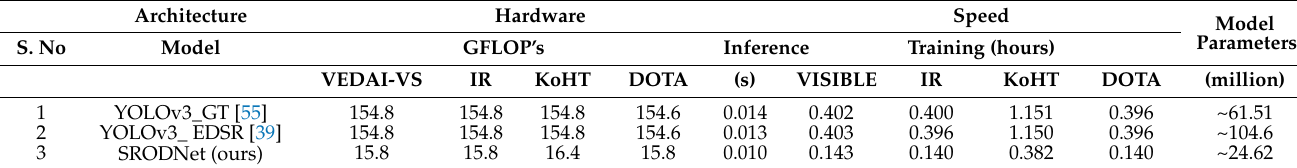
Table 5. Comparison of speed performance of the proposed and existing models.